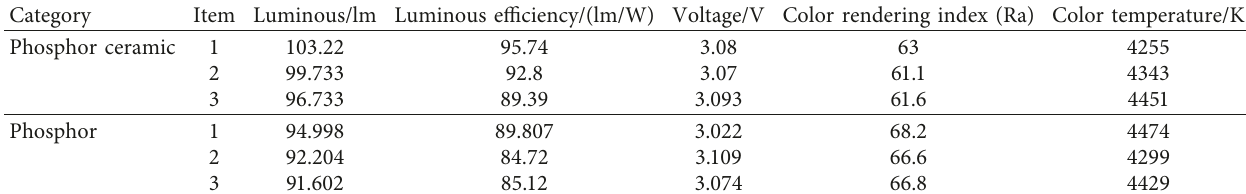
Figure 2: Excitation spectroscopy: (a) phosphor before calcination, (b) passes through a fluorescent powder after calcination of 1600 ° C, (c) fluorescently doped concentration of 5% fluorescence transparent ceramic, and (d) fluorescent powder doped concentration of 10% fluorescent transparent ceramics (em � 532nm). Table 1: Light effect comparison